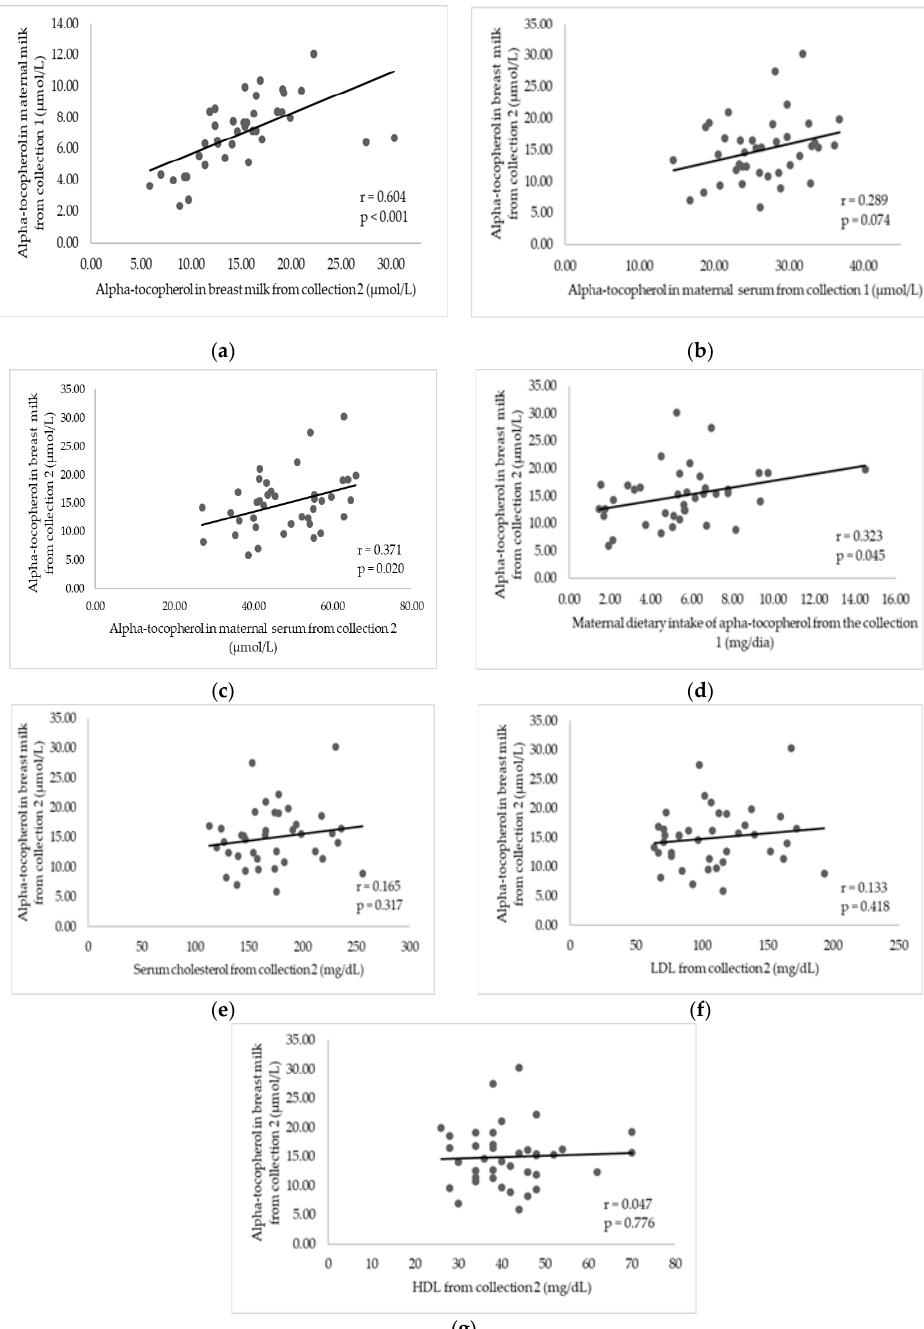
Figure 2. Correlations between alpha-tocopherol in breast milk obtained in collection 2 and maternal variables of the supplemented group. Natal, Rio Grande do Norte, Brazil, 2017–2018. ( a ) Correlation between alpha-tocopherol in breast milk from collection 1 and 2; ( b ) correlation between alpha-tocopherol in breast milk from collection 2 and serum from collection 1; ( c ) correlation between alpha-tocopherol in breast milk in serum from collection 2; ( d ) correlation between alpha-tocopherol in breast milk of collection 2 and the vitamin E intake of collection 1; ( e ) correlation between alpha-tocopherol in breast milk from collection 2 and serum cholesterol from collection 2; ( f ) correlation between alpha-tocopherol in breast milk from collection 2 and low-density lipoprotein (LDL) from collection 2; ( g ) correlation between alpha-tocopherol in breast milk from collection 2 and high-density lipoprotein (HDL) from collection 2. r = Pearson’s correlation coe ffi cient; p value = level of significance ( p < 0.05 = statistically